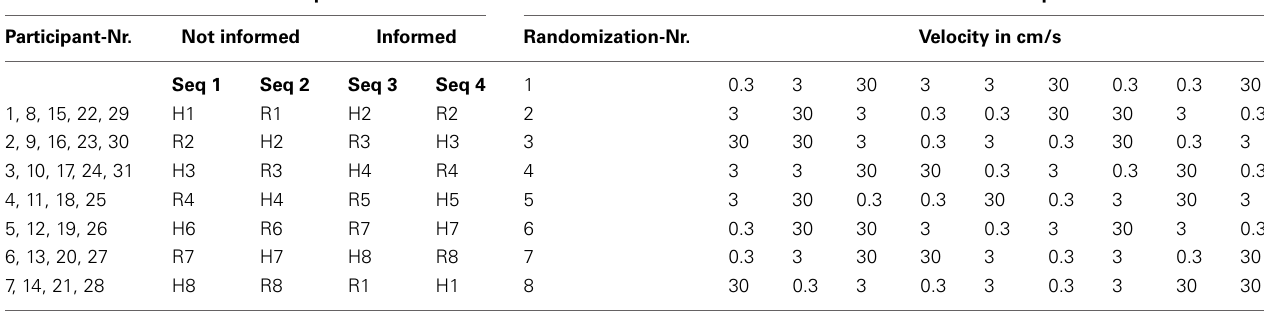
Table 2 | Randomization matrix. Randomization of sequences